Question: What visual encoding does this figure use to show its data?
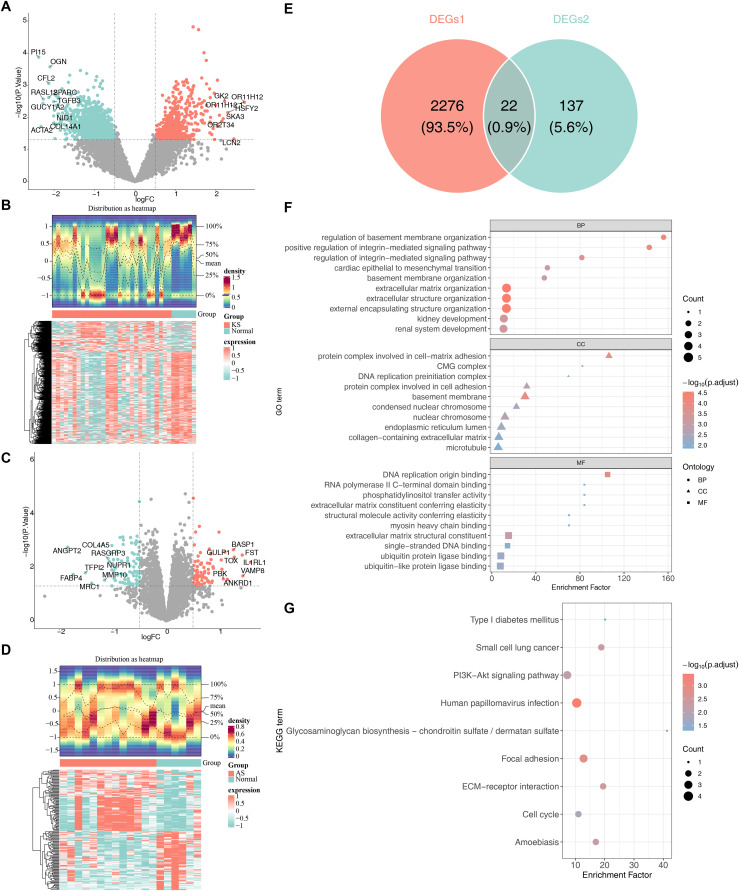
Answer: heatmap